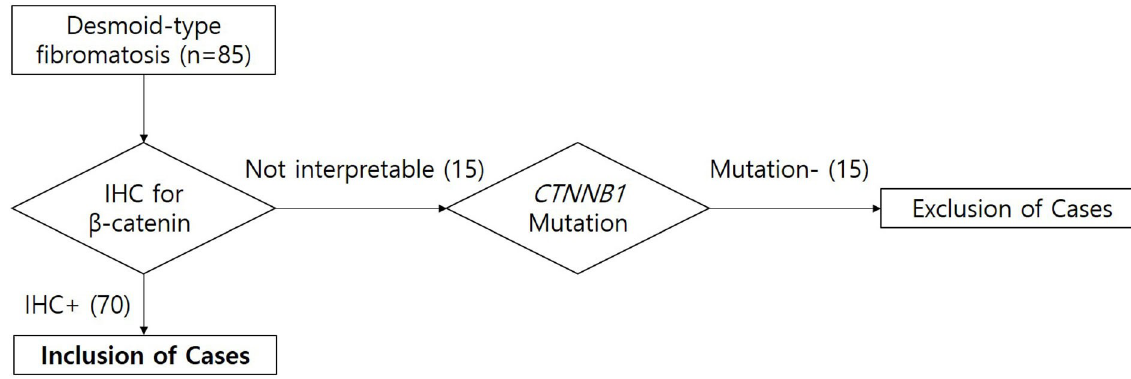
Fig 1. The algorithm for the selection of eligible cases of DF in this study. IHC, immunohistochemistry.